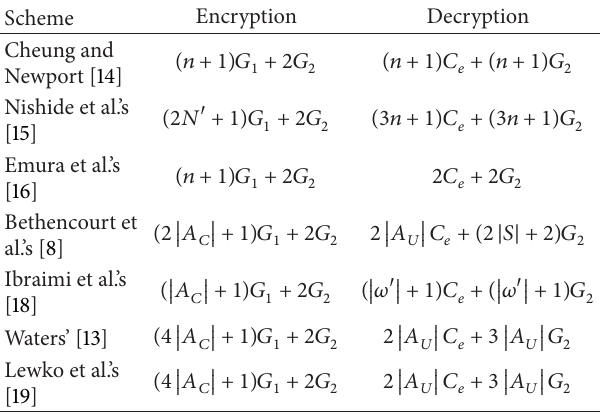
Table 3: Comparison of computational overhead in different CP- ABE